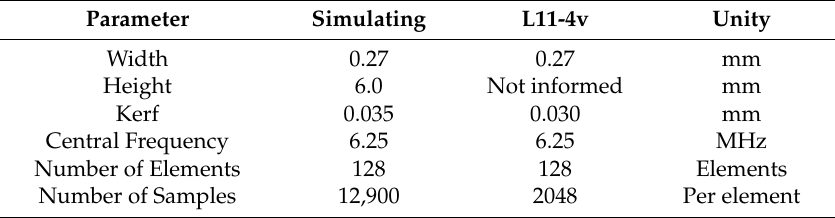
Table 2. Transducer parameters used for the simulation and experimental data acquiring